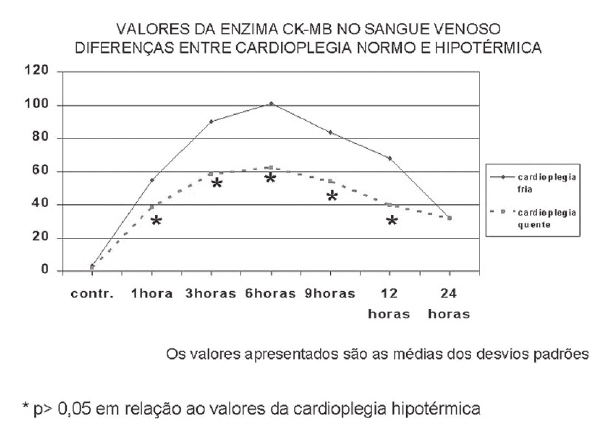
Fig. 4 – Valores da enzima CK-MB no sangue venoso. Diferenças entre cardioplegia normo e